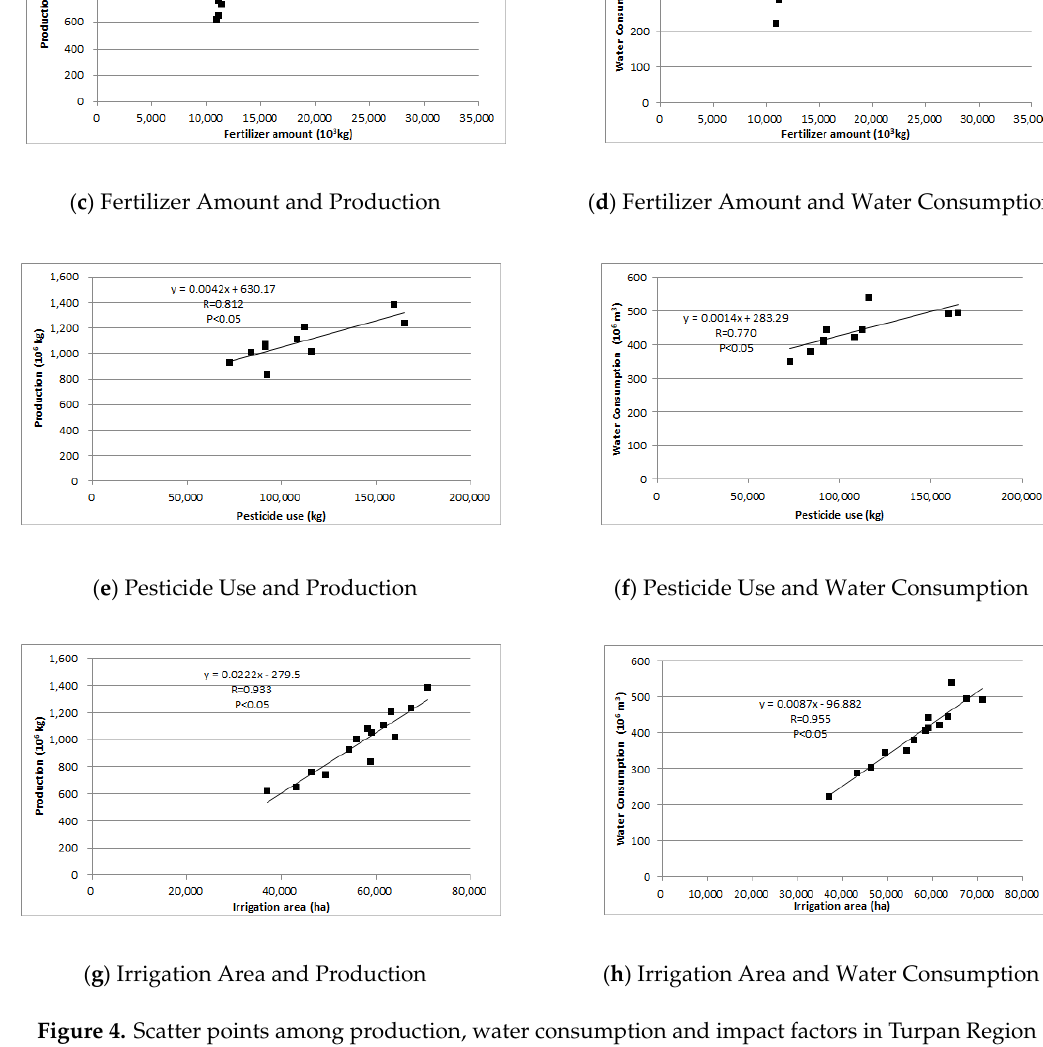
Figure 4. Scatter points among production, water consumption and impact factors in Turpan Region (temperature, fertilizer amount, film cover, and irrigation